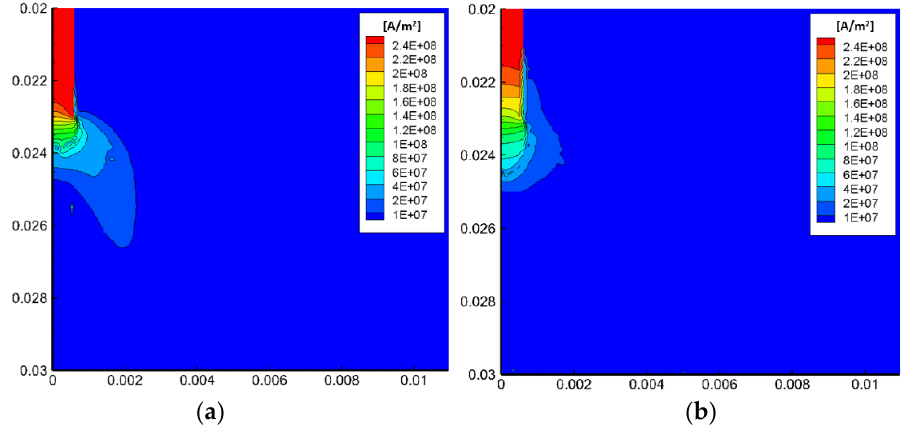
Figure 6. Current density distributions in ( a ) conventional MIG welding and ( b ) plasma – MIG welding.